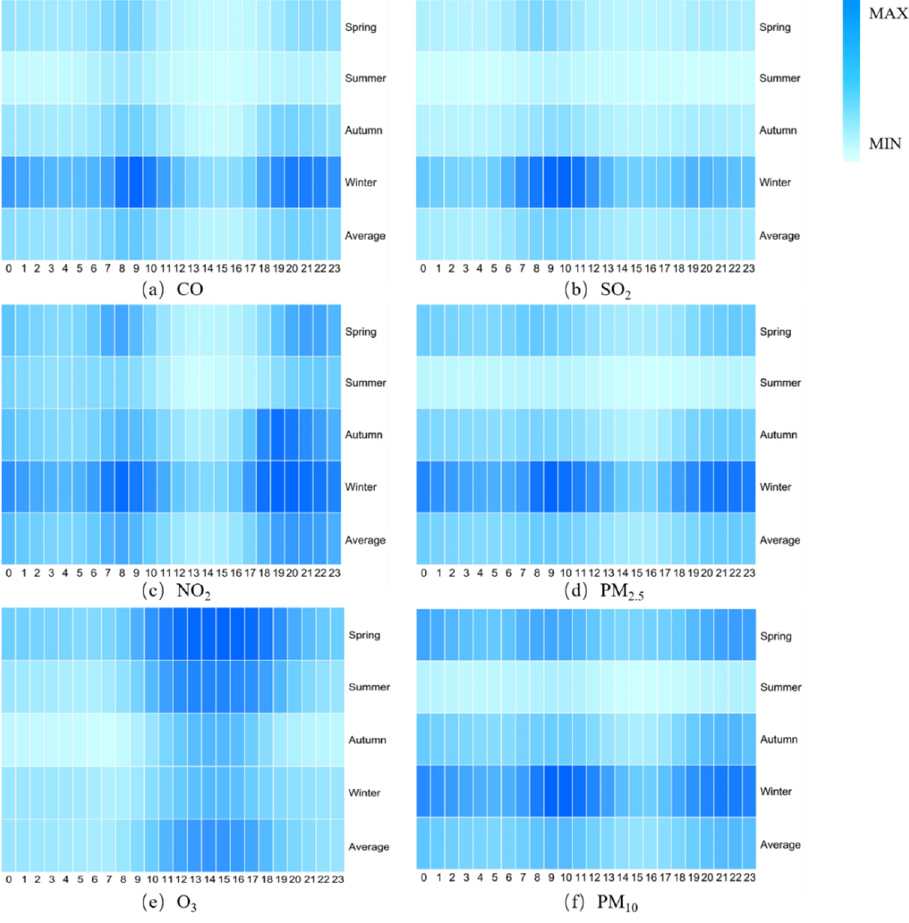
Figure 6. Hourly variation of six pollutant concentrations in different seasons from 2015 to 2020. ( a ) CO; ( b ) SO 2 ; ( c ) NO 2 ; ( d ) PM 2.5 ; ( e ) O 3 ; ( f ) PM 10 . (The CO concentration range is 0.65–1.46 mg/m 3 . The SO 2 concentration range is 7.27–51.99 μ g/m 3 . The NO 2 concentration range is 11.35–39.92 μ g/m 3 . The PM 2.5 concentration range is 16.08–75.31 μ g/m 3 . The O 3 concentration range is 27.97–120.63 μ g/m 3 . The PM 10 concentration range is 30.31–101.78 μ g/m 3 ).